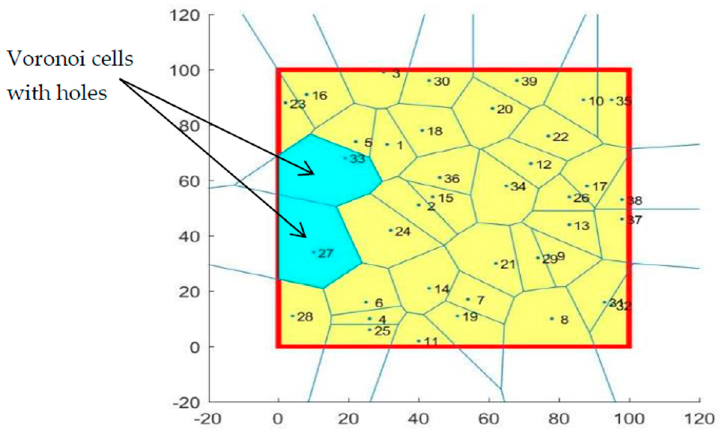
Figure 9. Voronoi cells of remaining 39 sensors.